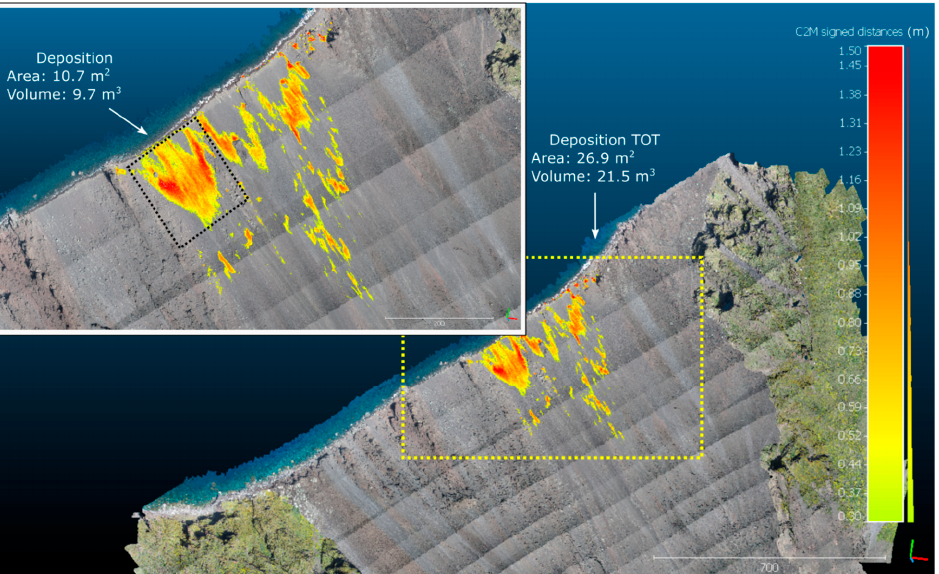
Figure 9. Stromboli 6–Stromboli 5 difference evaluated in an area close to the coastline after the usage of the Iterative Closest Point (ICP) alignment tool. Points within the yellow square are those taken into account for the realignment.